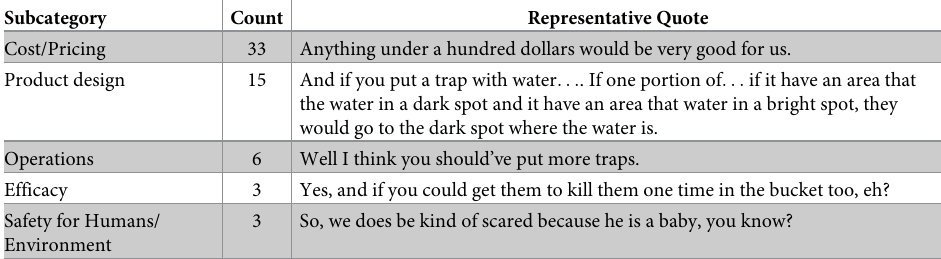
Table 7. Subcategories of recommendations offered by